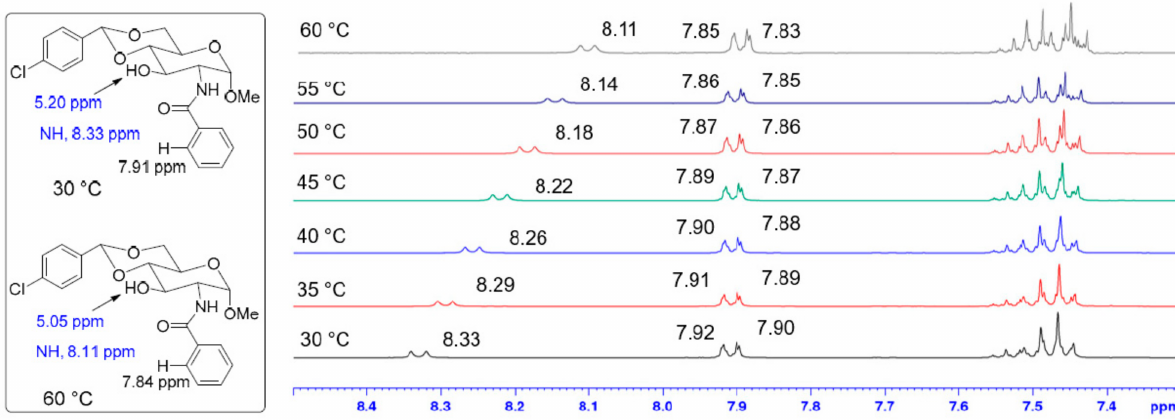
Figure 7. Stacked 1 H-NMR spectra of compound 13 at temperature 30–60 ◦ C from 7.4 to 8.5 ppm. Sample was prepared at 10.0 mg/mL in DMSO-d 6